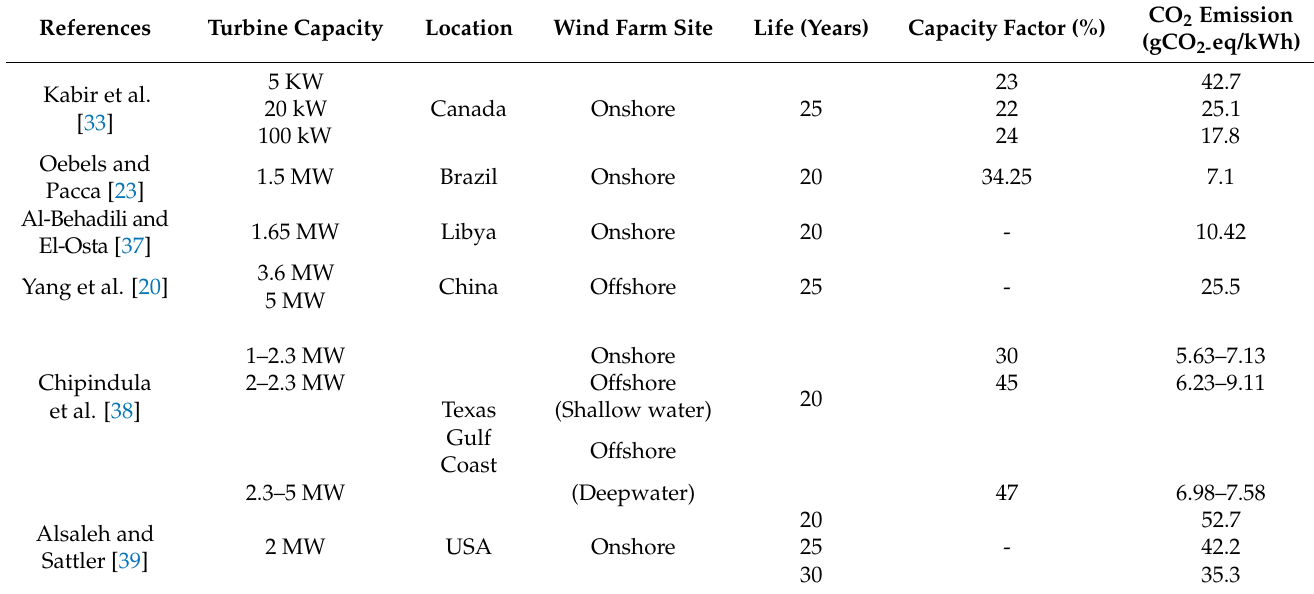
Table 1. CO 2 emissions for wind power at different